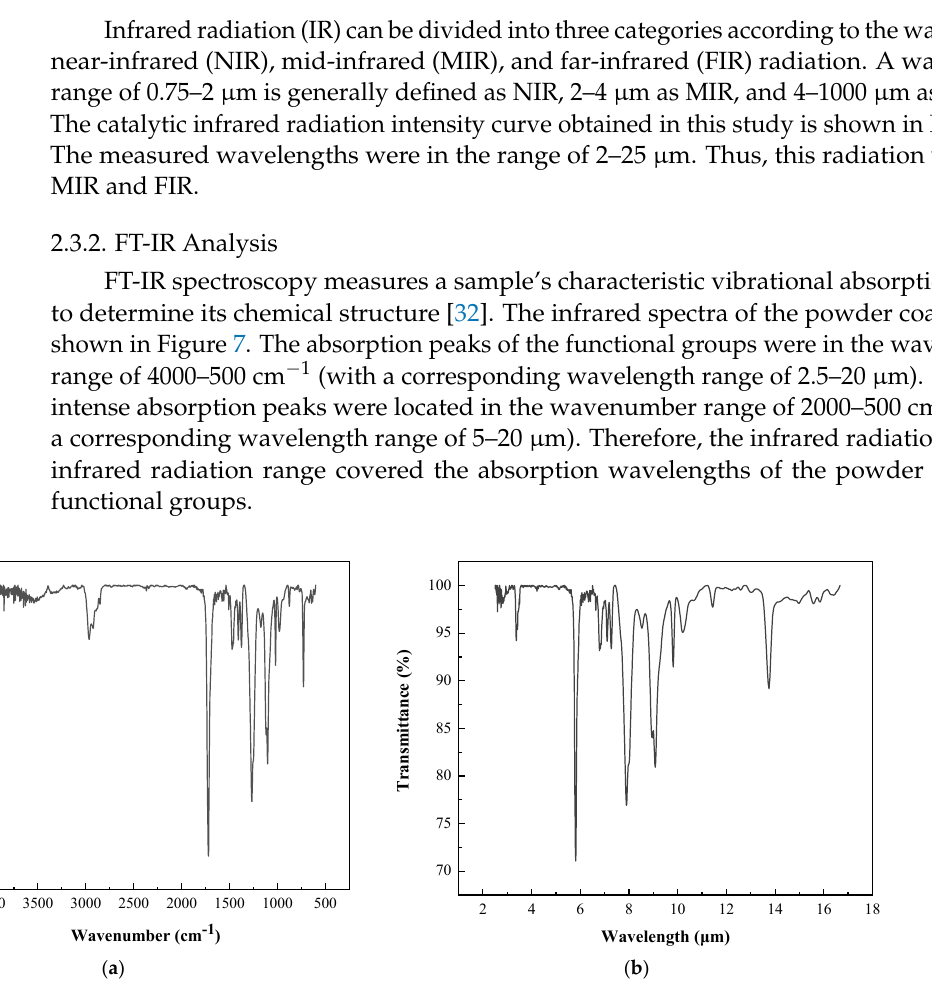
Figure 7. The infrared spectra of the polyester ‐ based/TGIC powder coating: ( a ) variation with wavenumber and ( b ) variation with wavelength.